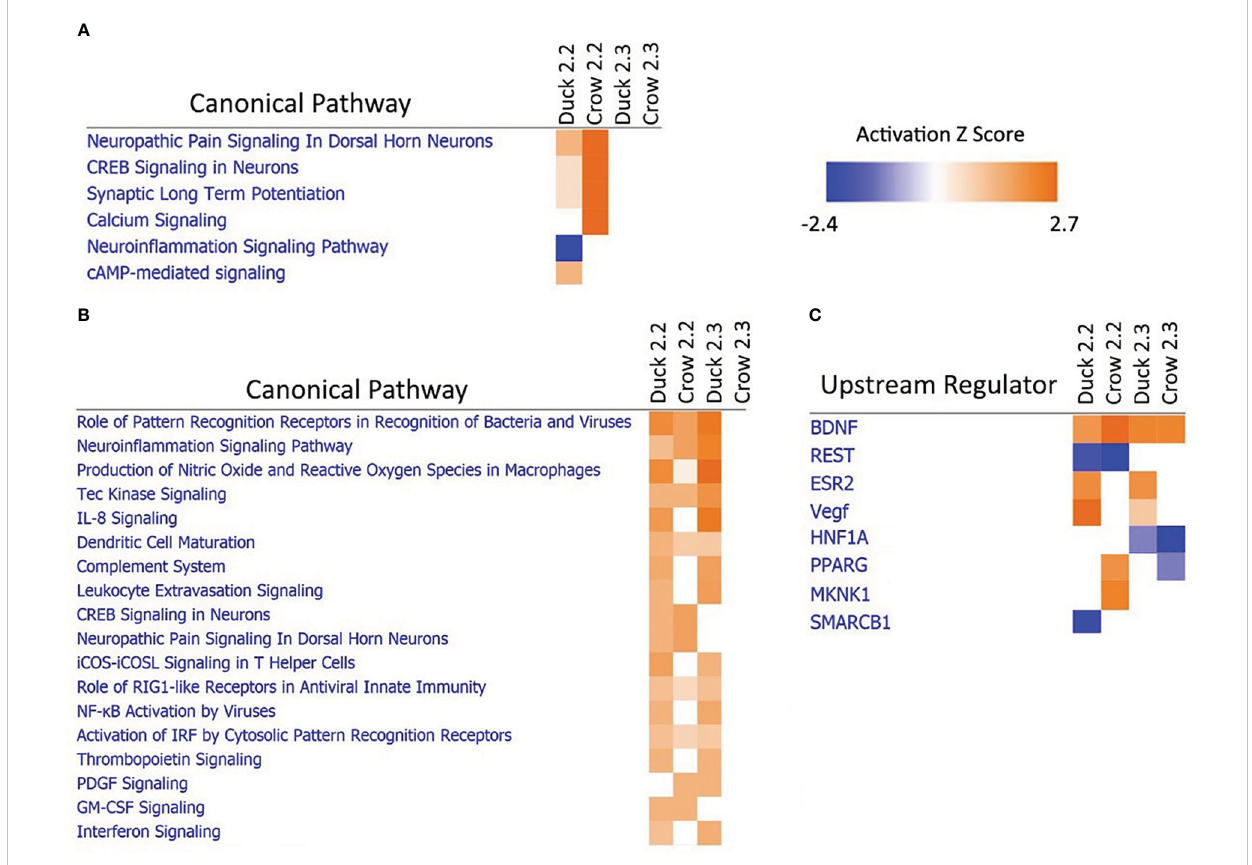
FIGURE 7 Pathway analysis of crow and duck lung at (A) 12h and (B) 48h and upstream regulators at 12h (C)